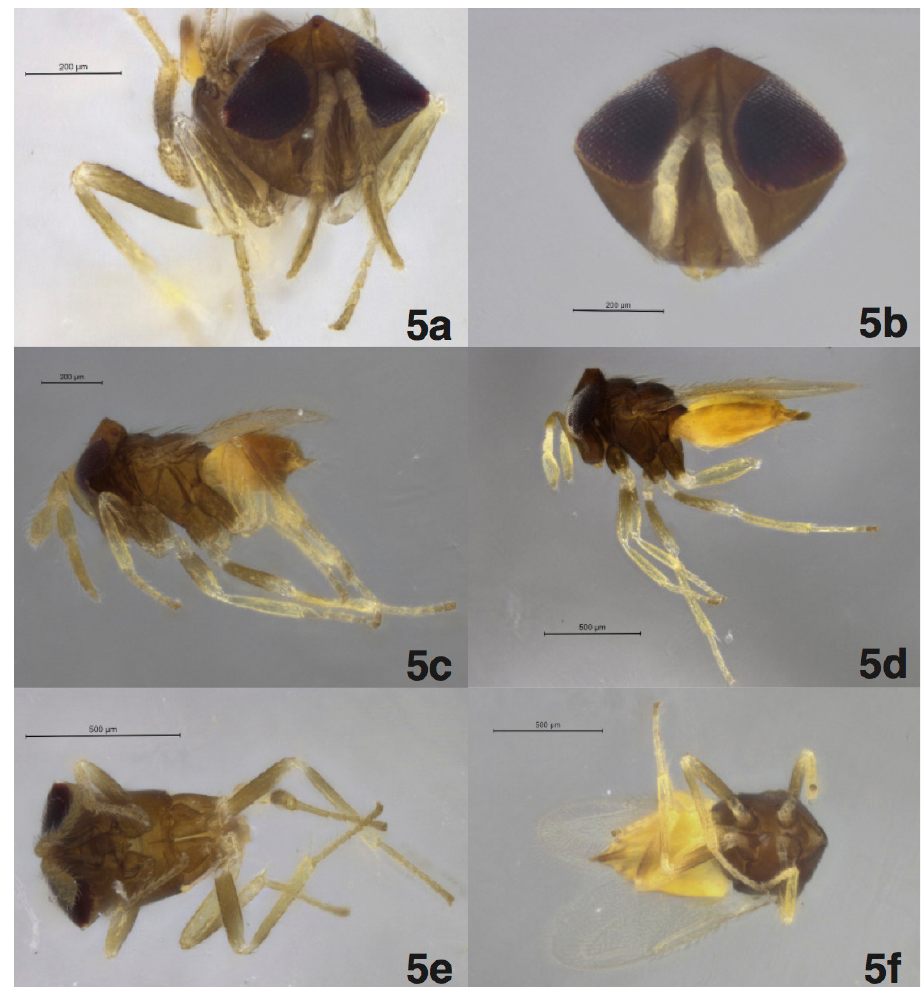
Figure 5. Aphelinus kazakhstanensis , paratypes in 95% ethanol 5a male, antennae and face, anterior view (TAMU-ENTO X0856689) 5b female, antennae and face, anterior view (TAMU-ENTO X0856403) 5c male, habitus, lateral view (TAMU-ENTO X0856689) 5d female, habitus, lateral view (TAMU-EN- TO X0856400) 5e male, habitus, ventral view (TAMU-ENTO X0856689); 5f : female, habitus, ventral view (TAMU-ENTO